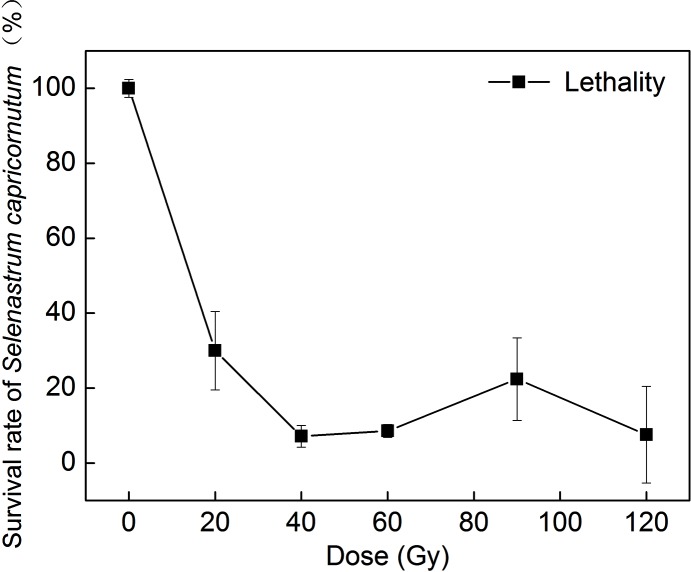
Survival rate of Selenastrum capricornutum after various doses of carbon-ion irradiation.n = 3±SD.